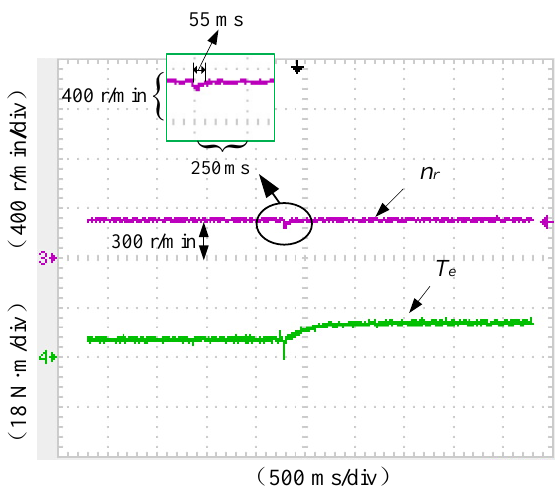
Figure 26. Experimental results of TIBC-DTC under load step change (5.5–11.5 N·m).